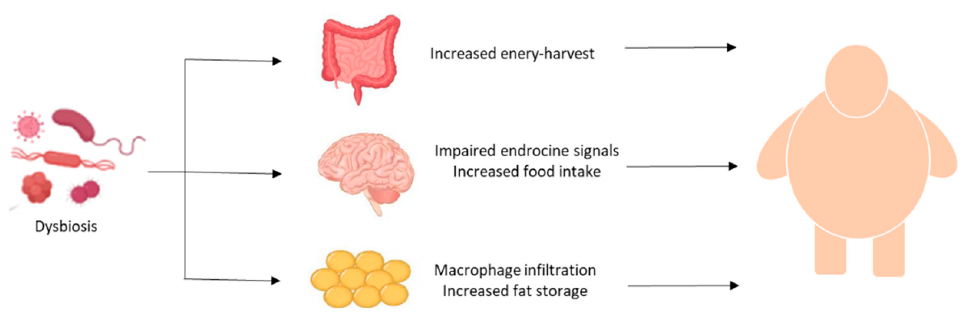
Figure 2. Main mechanisms linking dysbiosis and obesity.